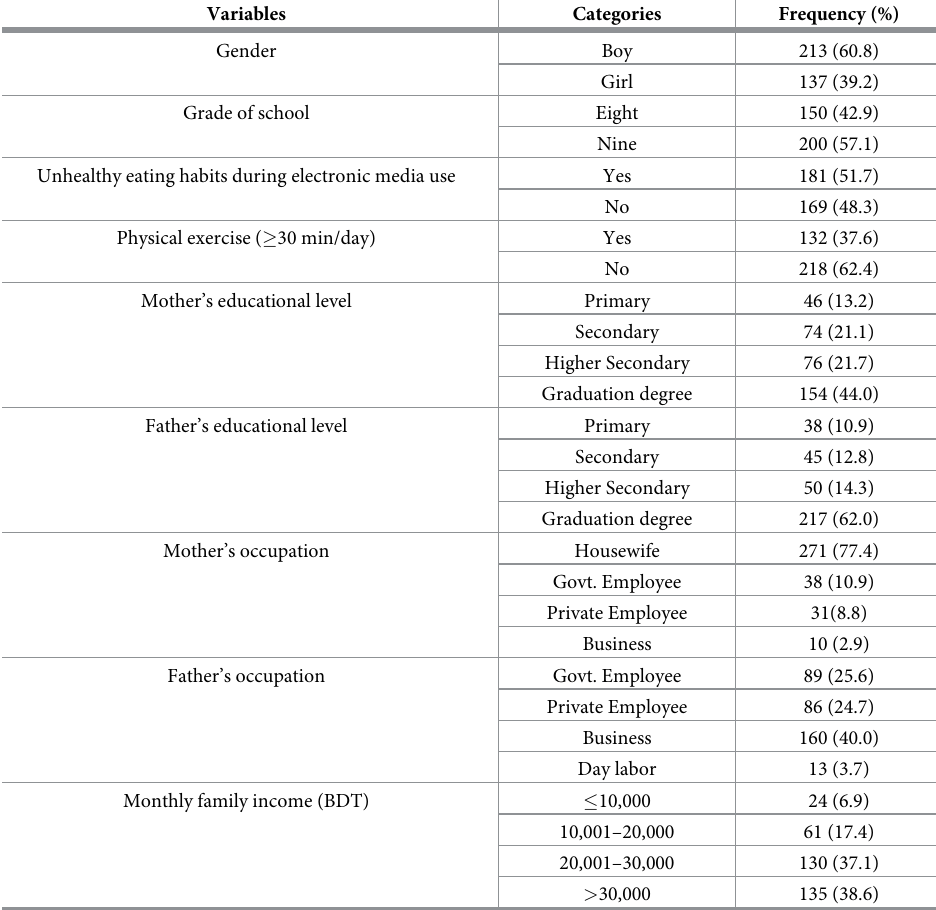
Table 1. Background characteristics of study